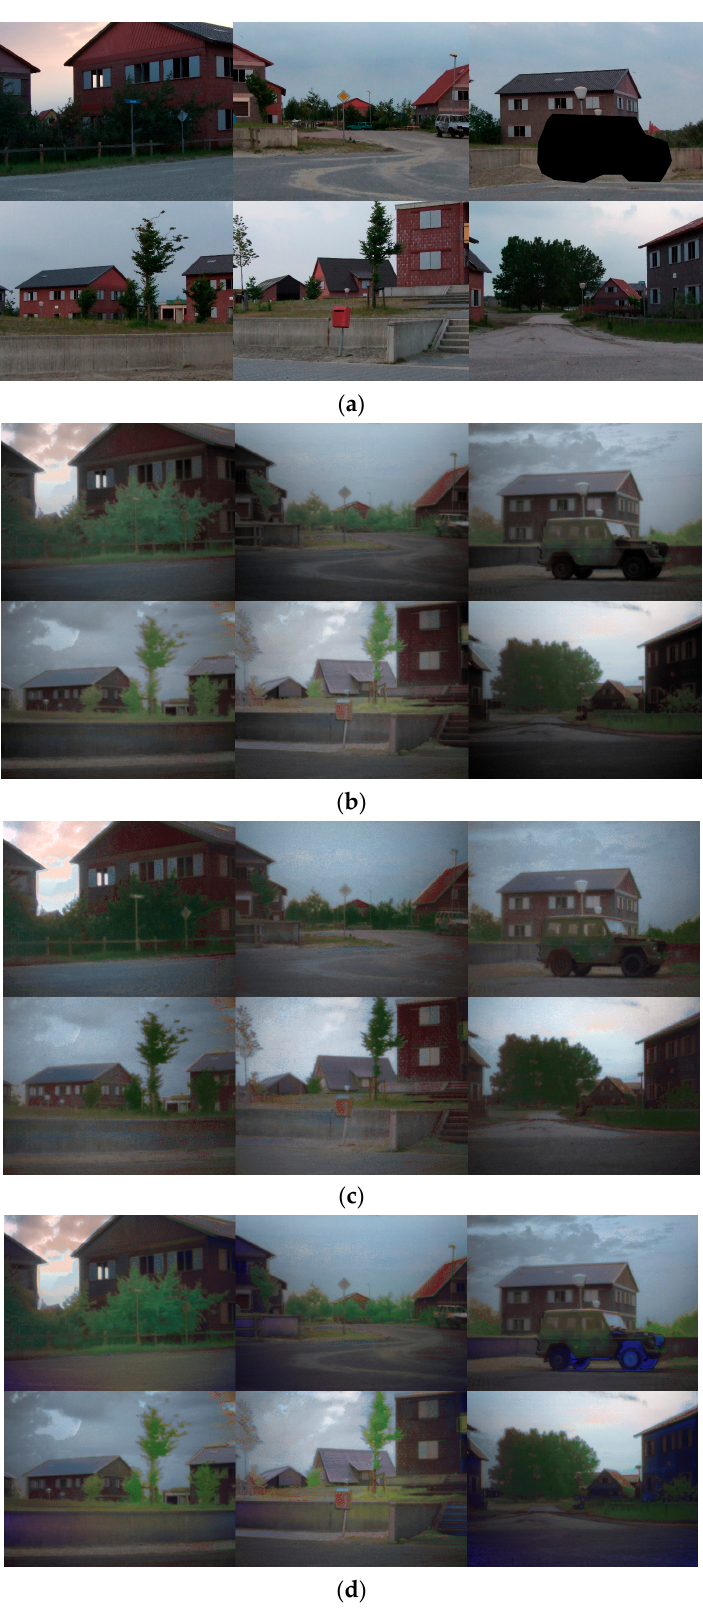
Figure 6. ( a ) Standard training set of daytime reference images; ( b ) Result of the CTN algorithm using the images in ( a ) for reference; ( c ) Result from the LFF method; and from ( d ) the SHT method (the training and test sets were the same in these cases).